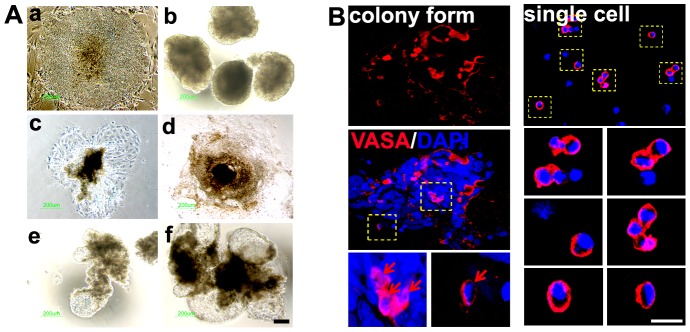
Differentiation of embryoid bodies (EBs) into male germ stem cell (GSC)-like cells.(A) Effects of treatment (EB medium; Non-treated, EB medium+BMP4, EB medium+RA or EB medium +BMP4/RA group) of EBs on the morphological features and induction of GSC-like cells after culture for 4 days. Scale bars: 50 µm. a; undifferentiated CHA hES 15, b: embryoid body from CHA hES 15, c; EB medium, d; EB medium+BMP4, e; EB medium+RA, f; EB medium +BMP4/RA group (B) Immunocytochemical staining using anti-VASA antibody on 4-day-old EBs (the left panel) and dissociated cells (the right panel). The yellow box indicates the magnified area. The red arrows indicate the signals for VASA fluorescence. Note: Scale bars are 20 µm.